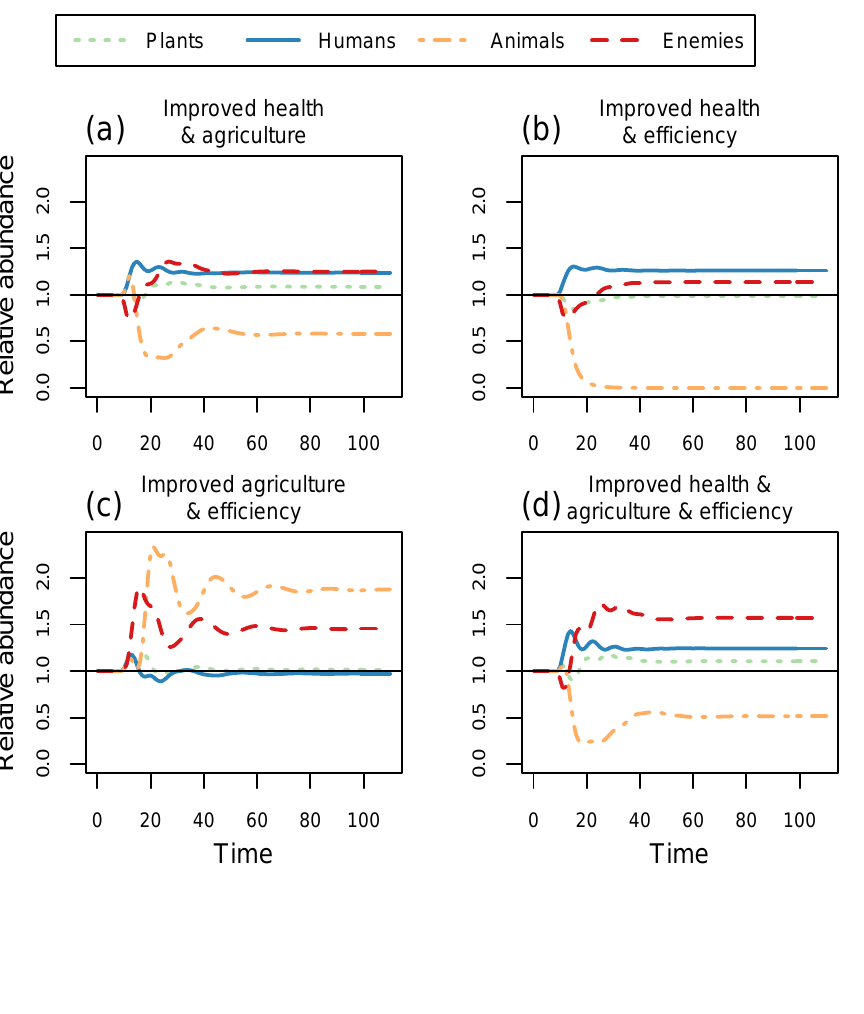
Figure A1.1. Effects of improvements in health, agriculture, and/or resource use efficiency on the abundances of humans, plant and animal resources, and shared natural enemies (e.g., zoonotic infections). As in Figure 2, except that the term c f AE was added to equation 4 and ae ae the term c AE was subtracted from equation 3. Here we assume that humans were less able to ae resist the shared natural enemies ( c = 1 < c = ae he